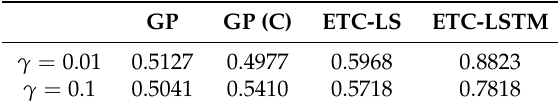
Table 2. CPU time (in s) comparison for the different ROM frameworks investigated in this study. Note that the elapsed CPU time for an FOM simulation (with 256 2 resolution) is about 103